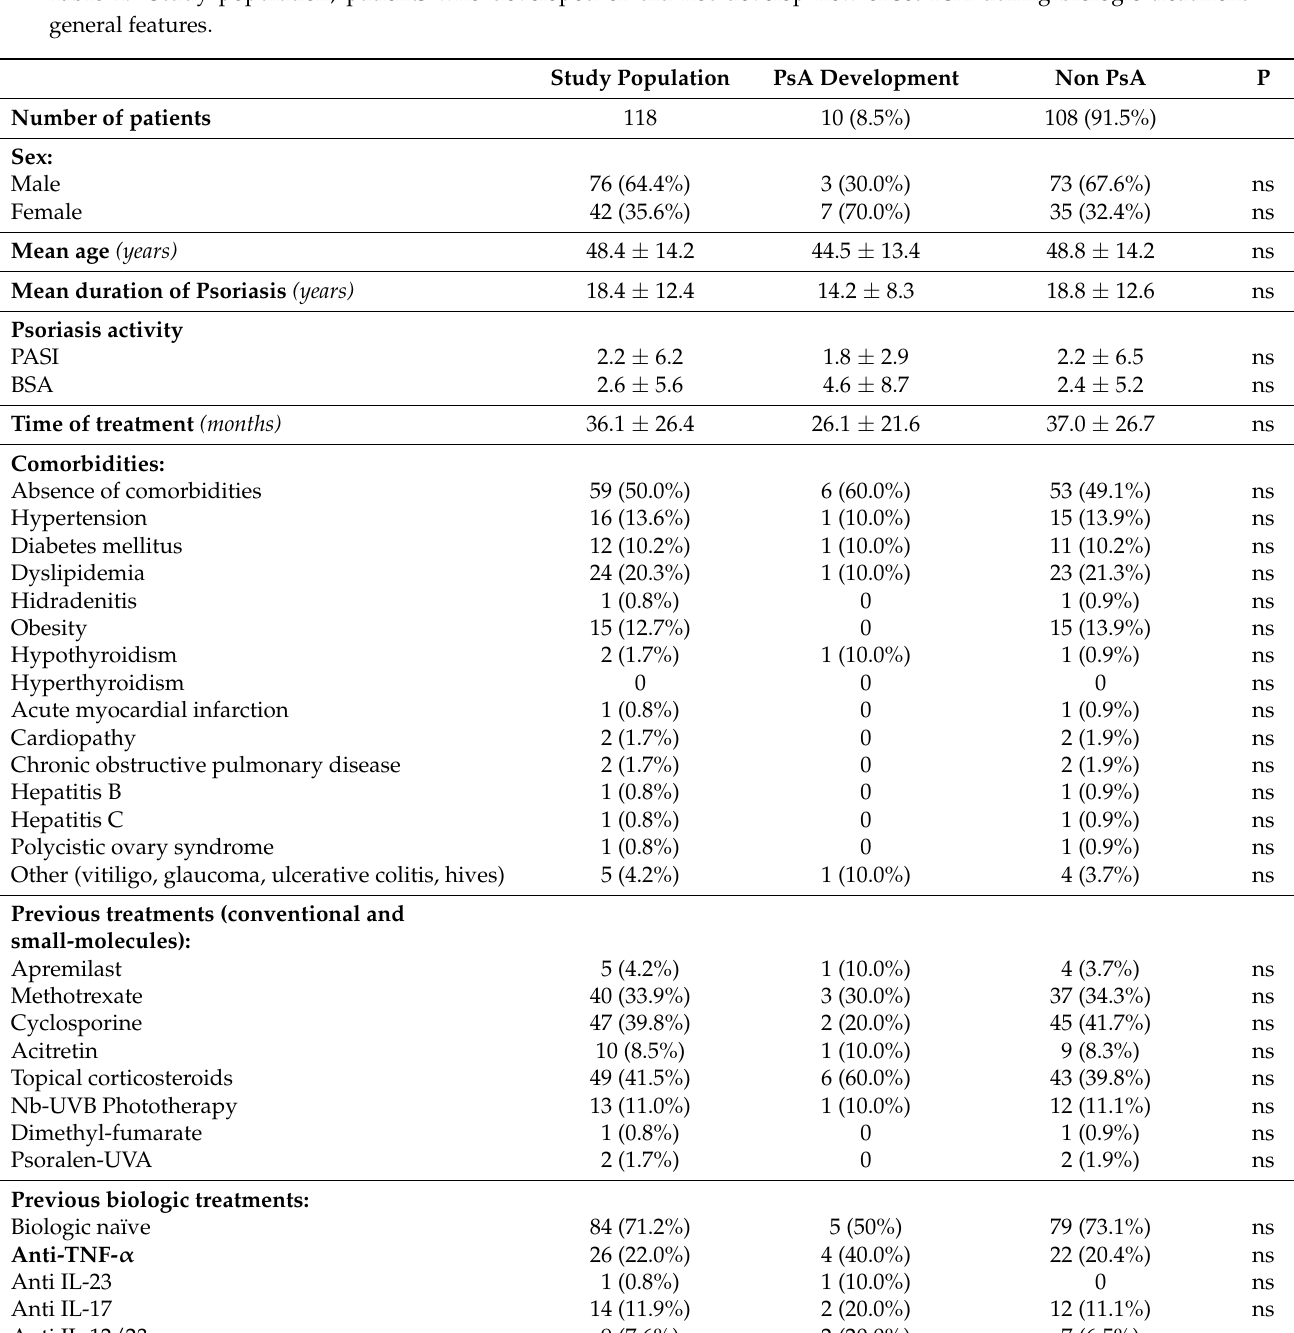
Table 1. Study population, patients who developed or did not develop new-onset PsA during biologic treatment: general